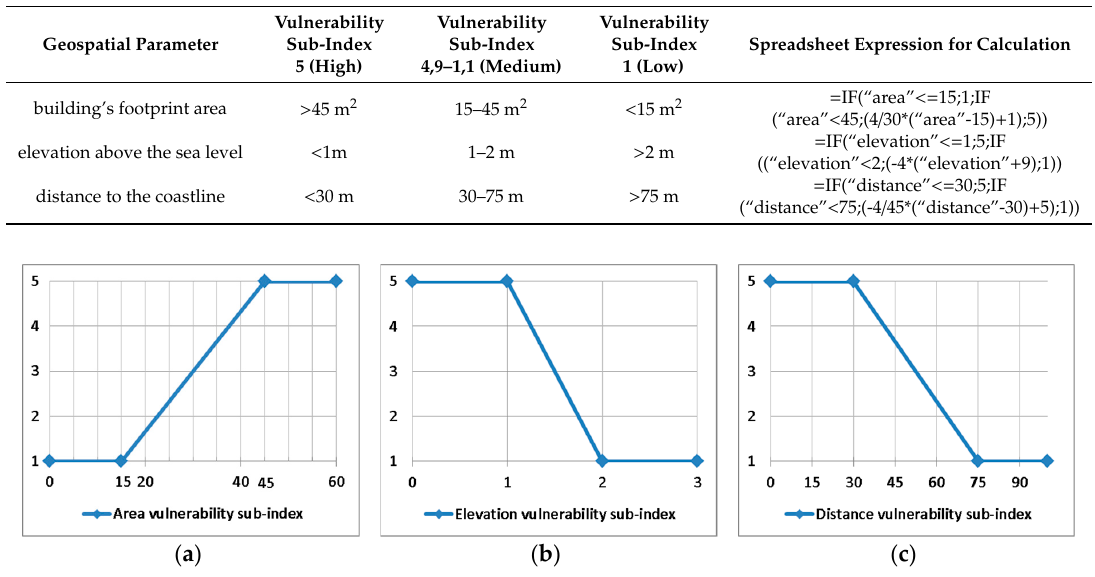
Table 2. Continuous rankings: the vulnerability sub-indices V area , V elevation, and V distance .